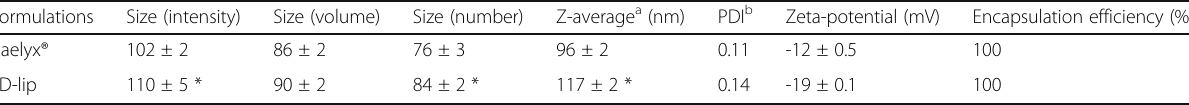
Table 1 Physicochemical characteristics of ED-lip and Caelyx®. Each value represents as mean ± standard deviation (S.D) ( n = 3)